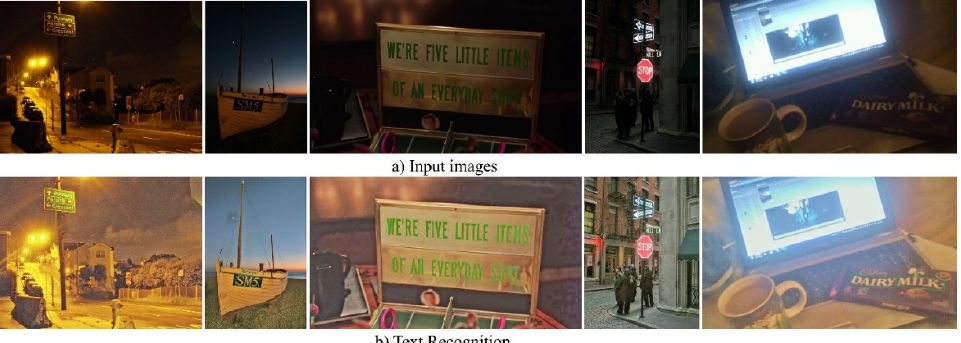
Figure 12. The results of the text detection and recognition for TTS on ExDark dataset.